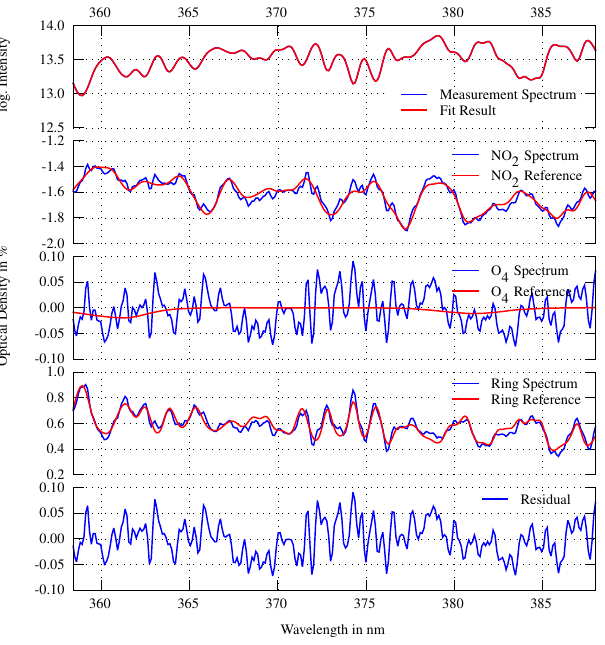
Figure 13. Sample NO 2 fit (dSCD ≈ 3.1 × 10 16 moleccm − 2 ) of a nadir measurement taken from the flight to Prudhoe Bay on 31 March 2012 at 01:58UTC. The red line shows the fitted ab- sorption structure whereas the blue line shows the fit result plus the